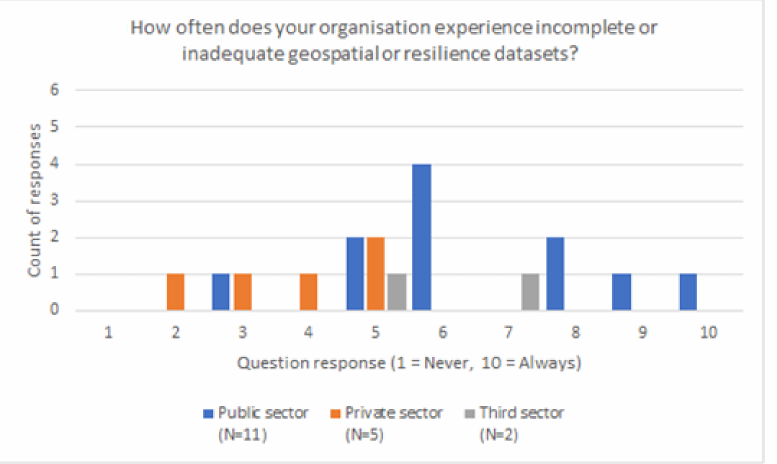
Figure 4. Number of responses per sector obtained for the following survey question: “How often does your organisation experience incomplete or inadequate geospatial or resilience